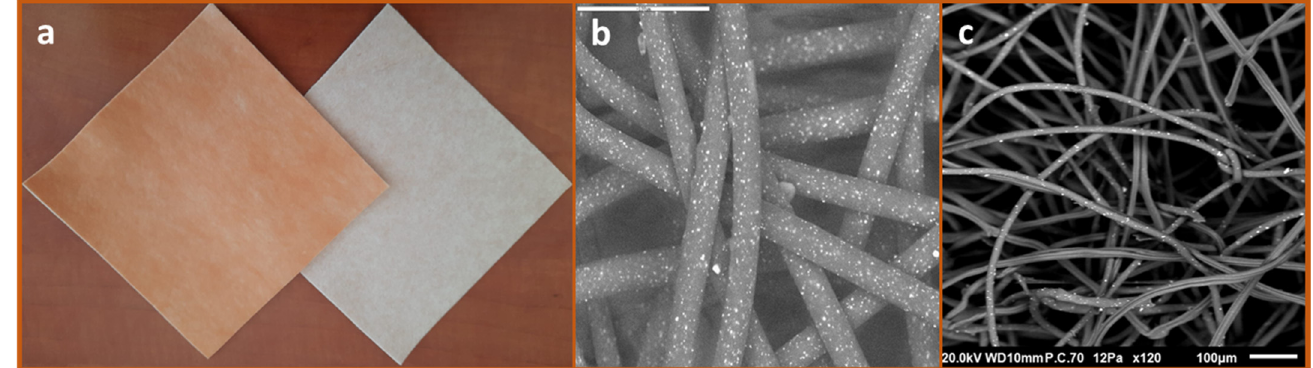
Figure 1. Cuprous oxide-impregnated wound dressings. The COD are composed of a highly absorbent layer (beige color) and one or two external non-adherent layers (orange color) ( a ). The cuprous oxide microparticles embedded in the fibers are the white dots seen in the scanning electronic microscopy images of the orange layer ( b ) and the absorbent layer ( c ).